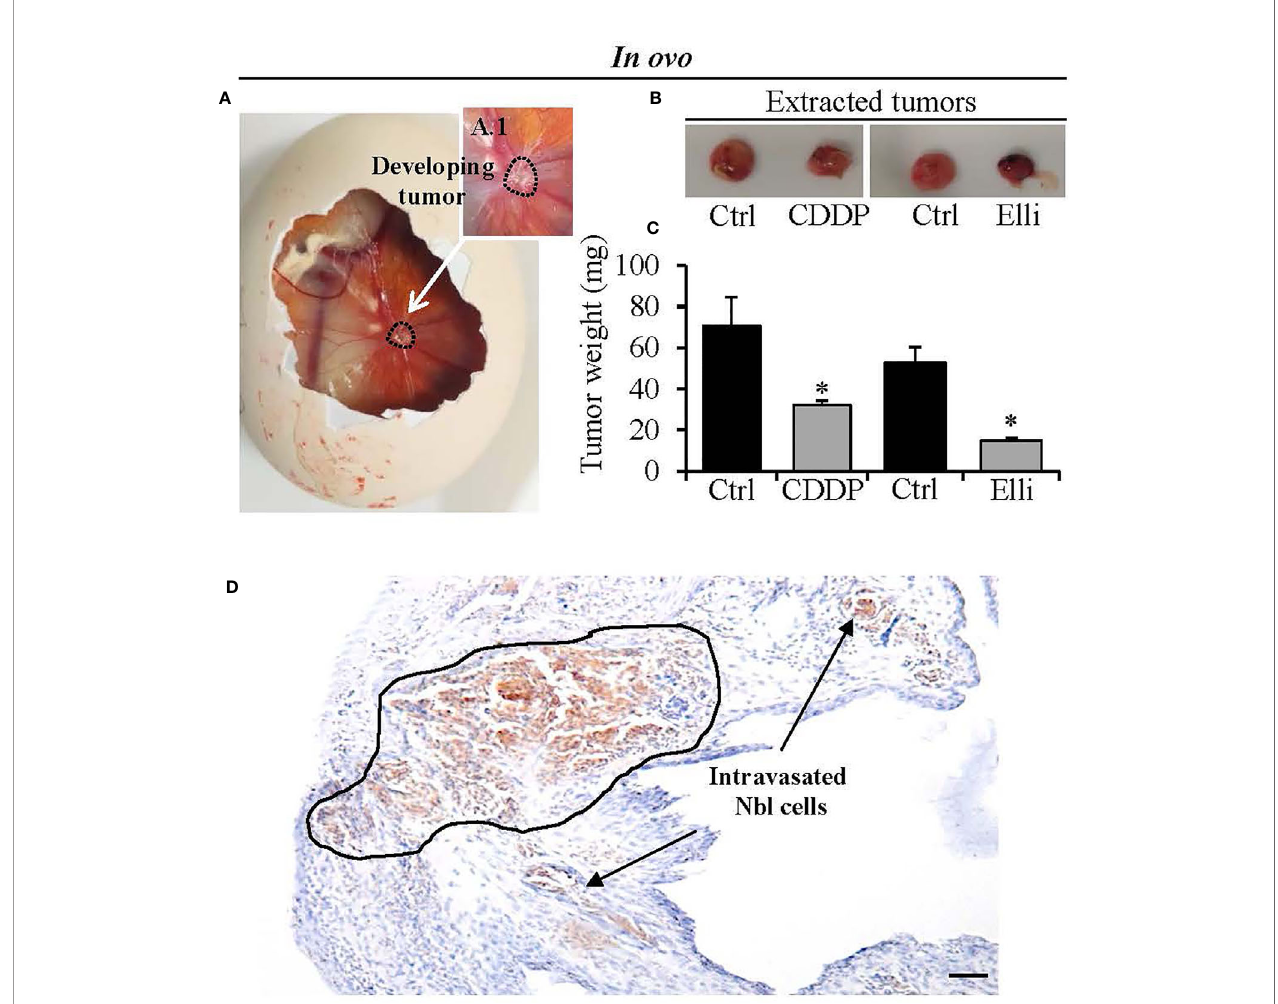
FIGURE 4 | Determination of ef fi ciency of treatment [cisplatin (CDDP) and ellipticine (Elli)] to inhibit growth of neuroblastoma (Nbl) xenograft. (A) In ovo chick chorioallantoic membrane (CAM) assay photograph showing representative CAM with the Nbl tumor formed at the seventh day after xenografting. (B) Photographs and (C) tumor weights after excision from the CAM (upon experiment termination on the 17th day). (D) Immunohistochemical visualization of CD44 expression in Nbl cells forming primary tumor and outgrowing from primary tumor by disrupting the CAM upper epithelium (black demarcation). Intravasated Nbl cells in the distal CAM are shown by arrows. Data show mean ± SEM from three ( n = 3) independent experiments. * p < 0.001. Scale bar, 200 m